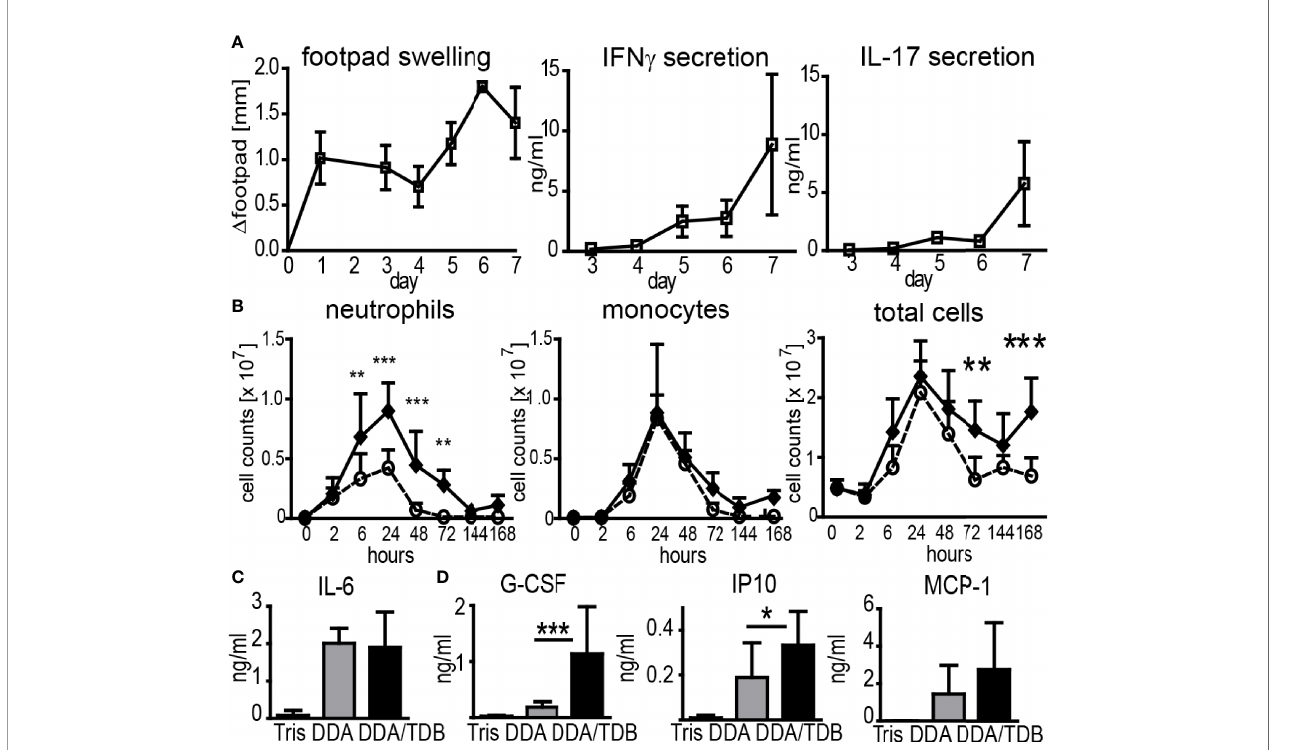
FIGURE 1 | DDA/TDB induces rapid in fl ux of neutrophils and monocytes to the SOI. (A) Kinetics of footpad swelling and IFN g and IL-17 secretion after s.c. injection of DDA/TDB/H1. Re-stimulation of pooled cells from popliteal and inguinal lymph nodes. (B) Recruitment kinetics after i.p. injection of DDA (open circles) or DDA/TDB (closed spheres). For gating strategies, see Supplementary Figure S1 . Pooled data from eight independent experiments, total n = 5 – 9 mice per group/time point. (C) IL-6 2 h and (D) G-CSF, IP10, and MCP-1 24 h p.i. in peritoneal lavage; Tris (vehicle control), DDA, or DDA/TDB. Pooled data from four independent experiments, a total of 6 – 12 mice per group. Signi fi cance tested by two-way ANOVA and Bonferroni correction (B) or t-test (C, D) . *p < 0.05, **p < 0.01, ***p <